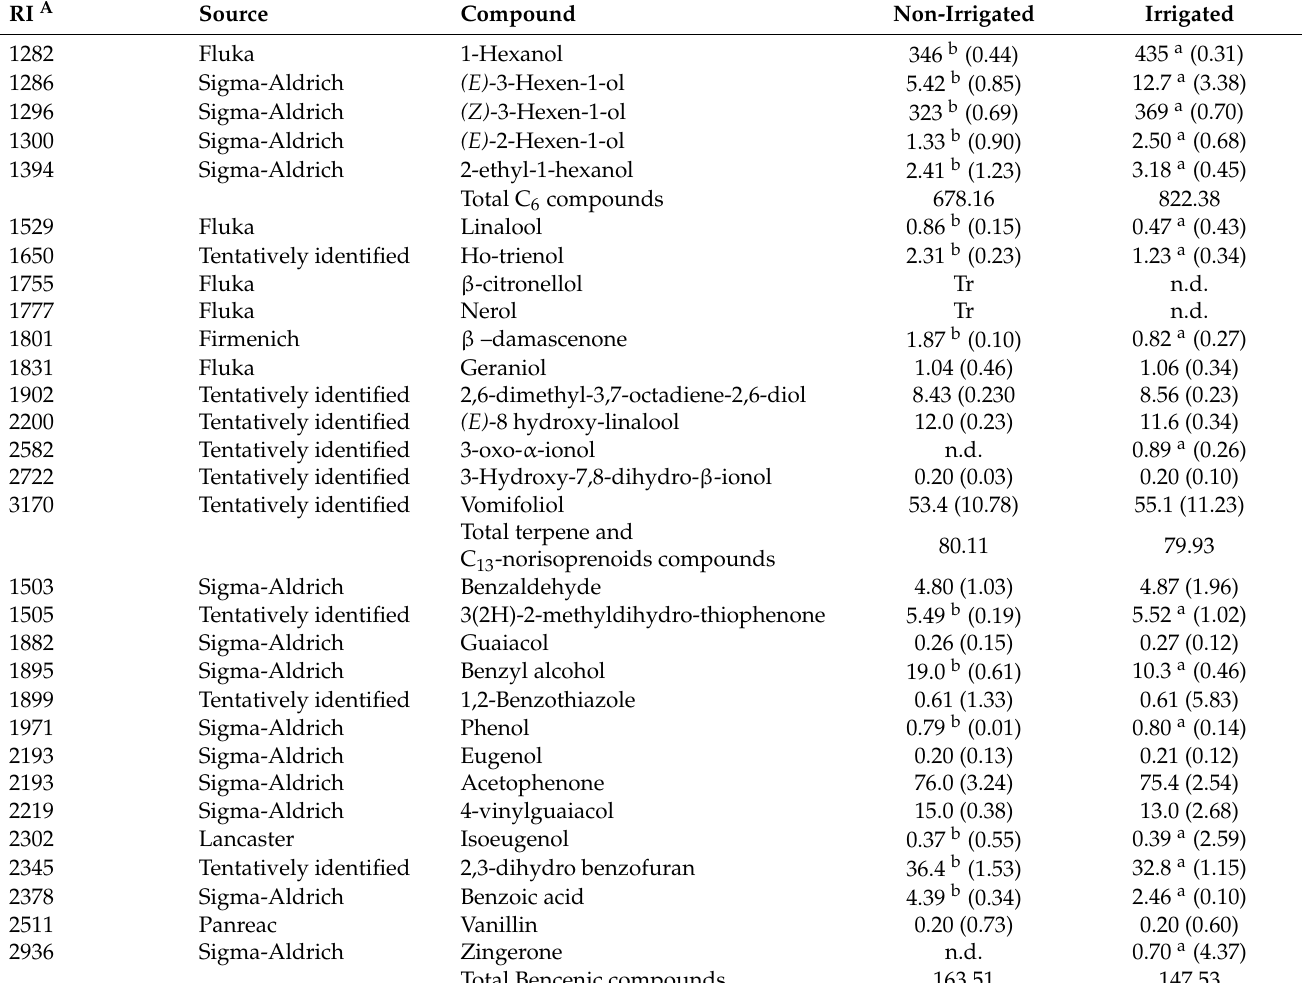
Table 2. Mean concentrations of varietal volatile compounds ( µ g/L) and relative standard deviations ( n = 4) of Chelva wines made with grapes from non-irrigated and irrigated